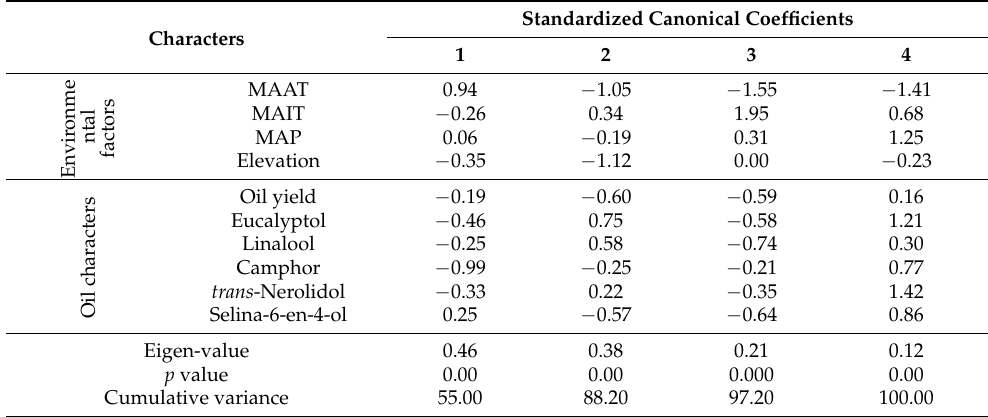
Table 6. Canonical coefficients for four CCA sets between phytochemicals with environmental